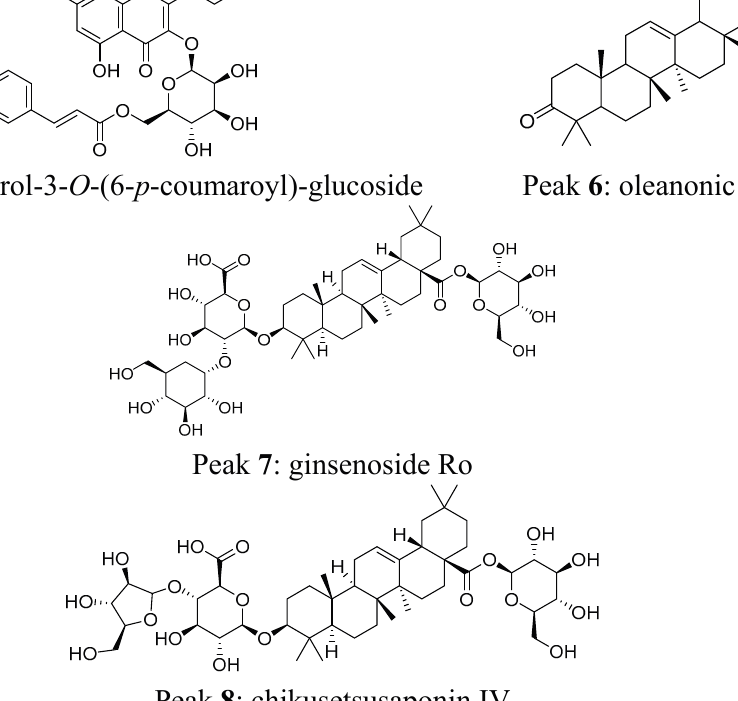
Peak 3 : quercetin-3- O -glucoside Peak 4 : kaempferol-3- O -glucoside